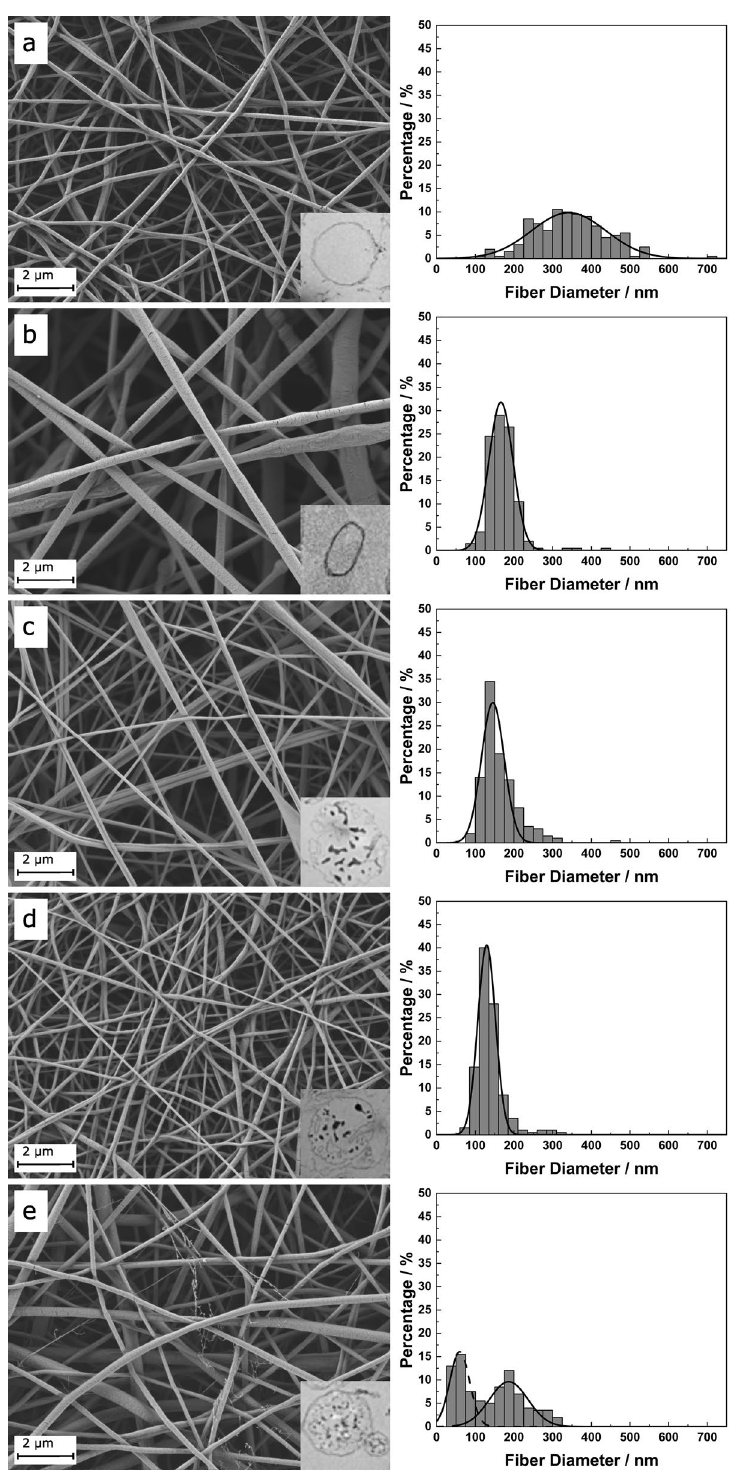
Figure 1. SEM images and corresponding fiber diameter distribution histograms. Insets show exemplary TEM images (0.25 µm in width and height) of the fiber cross sections: ( A ) PCL-1; ( B ) PCL-2; ( C ) PCL-COL; ( D ) PCL-GEL; ( E ) PCL-CHI. Fiber diameters from A-D are following a Gaussian distribution. In the case of PCL- CHI a bimodal distribution is